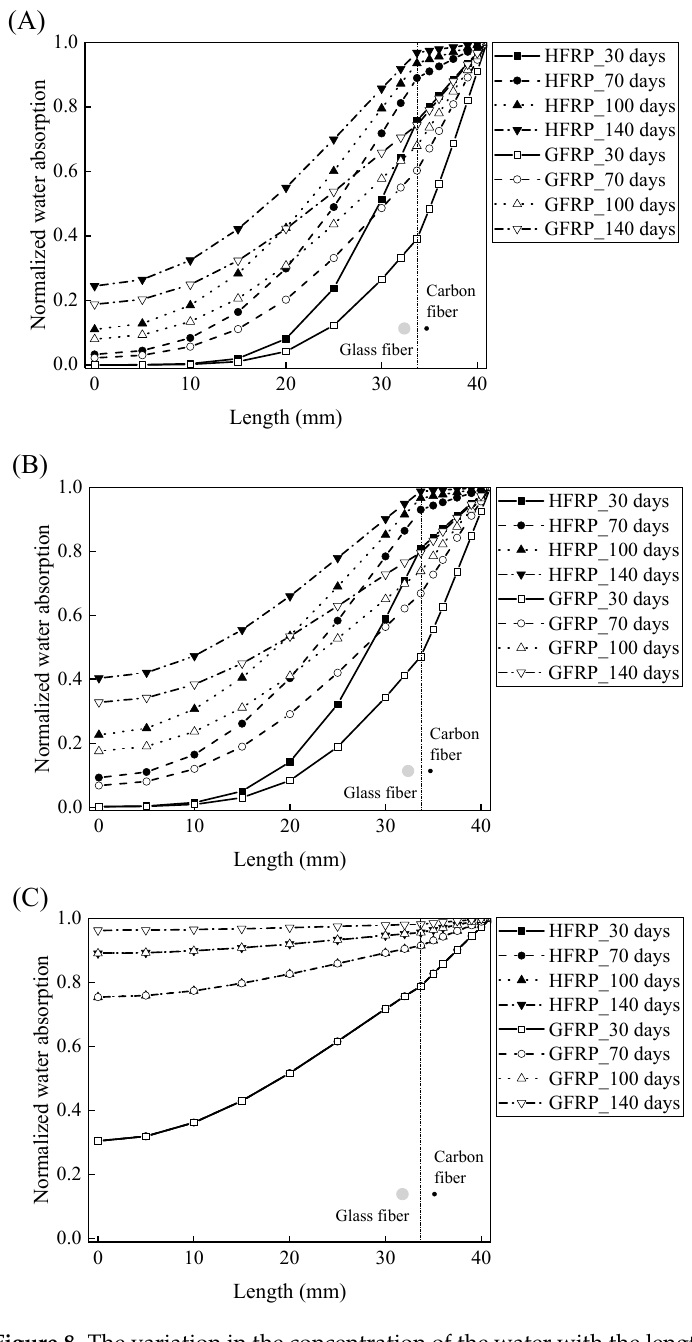
Figure 8. The variation in the concentration of the water with the length in the radial direction at a temperature of: ( A ) 21 °C, ( B ) 40 °C, and ( C ) 60 °C.